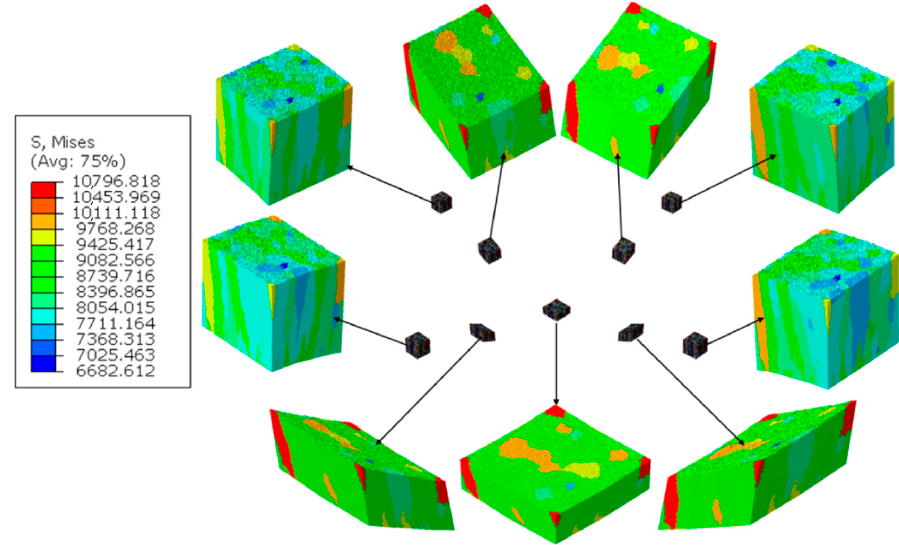
Figure 12. Equivalent stress distribution within the DMR (Digital Material Representation) model after nanoindentation test.